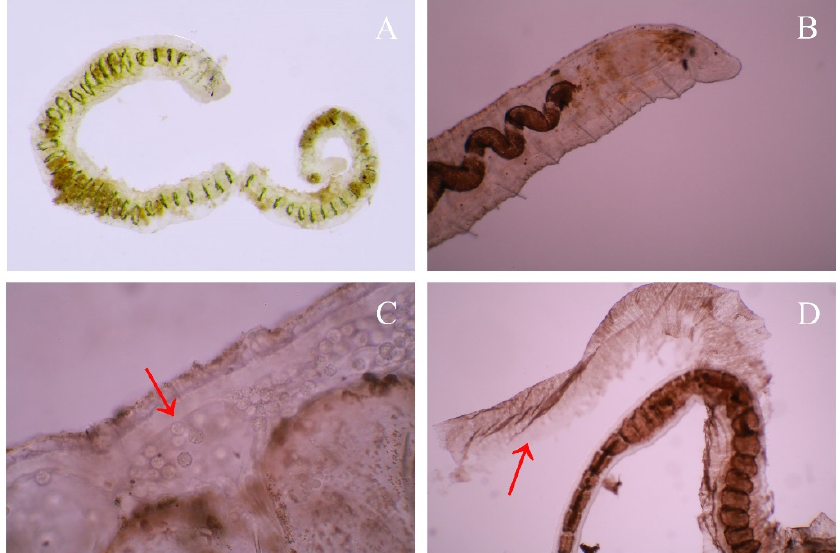
Figure 1. LM micrographs of Ophidonais serpentina specimens from China. ( A ) Complete individual, ( B ) eyes, ( C ) coelomocytes, and ( D ) thin crust of foreign particles. Observed from 4 × , 20 × , 40 × , and 10 × , respectively.